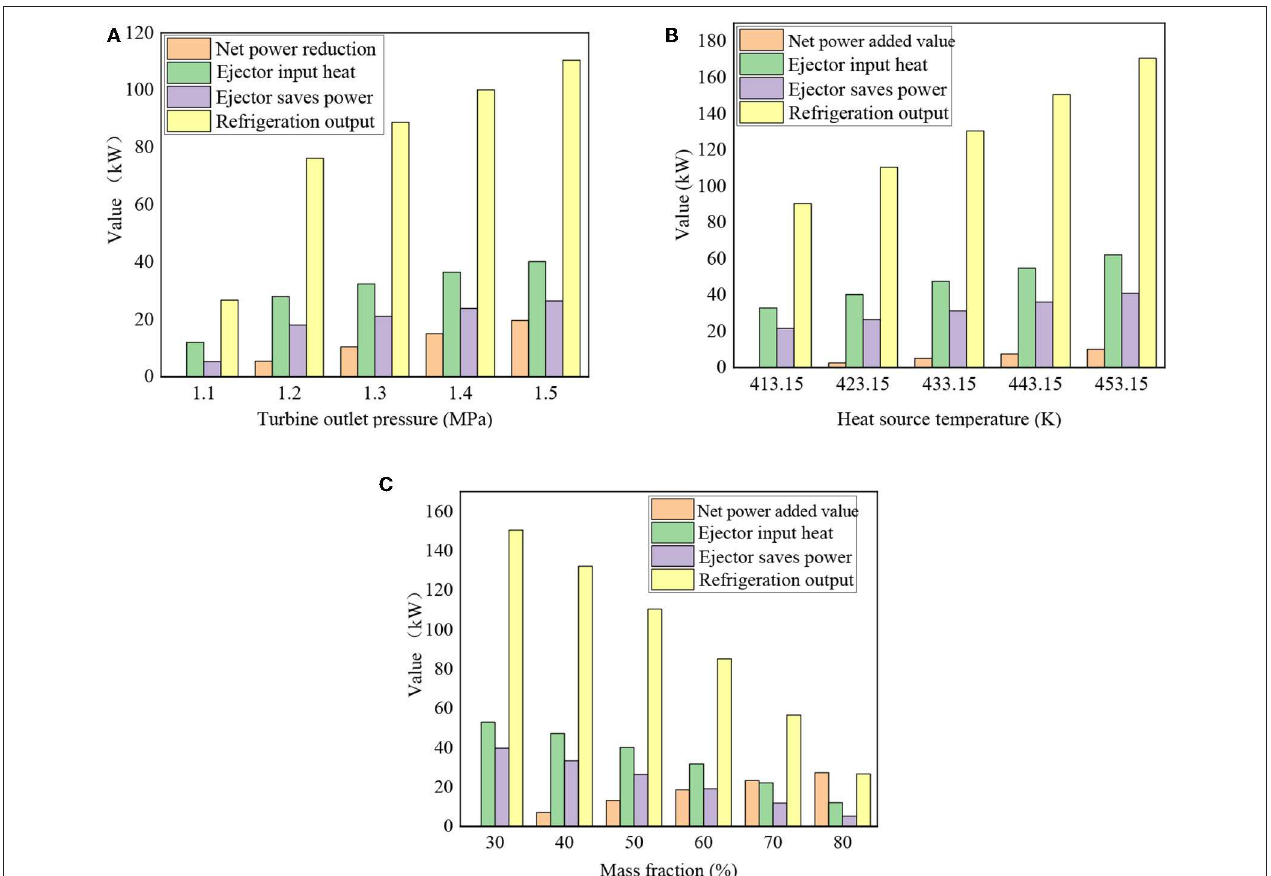
FIGURE 9 | Effect on the performance of ejector and the combined system. (A) Turbine outlet pressure; (B) heat source temperature; (C) mass fraction.